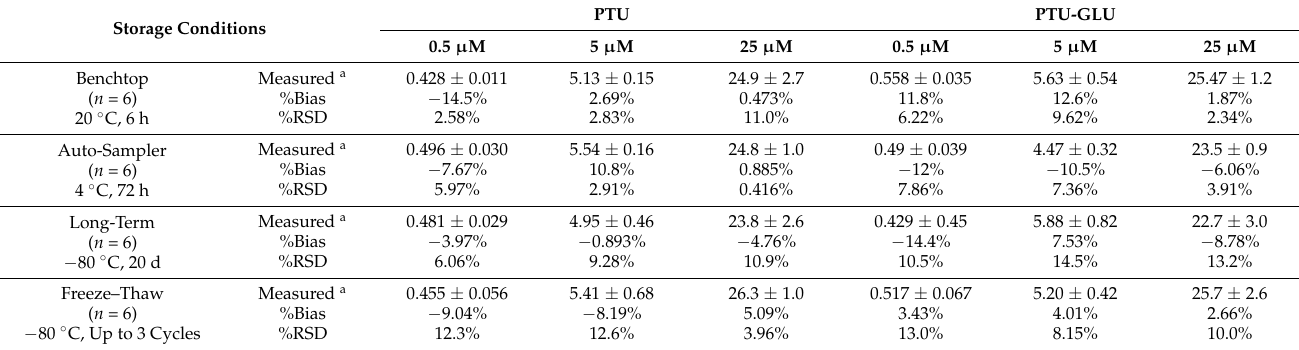
Table 4. Stability results for PTU and PTU-GLU at different storage